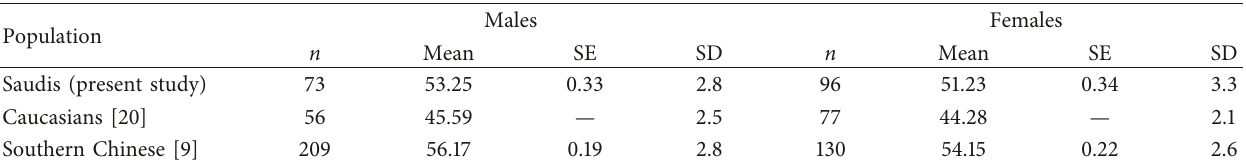
Southern Chinese [9]